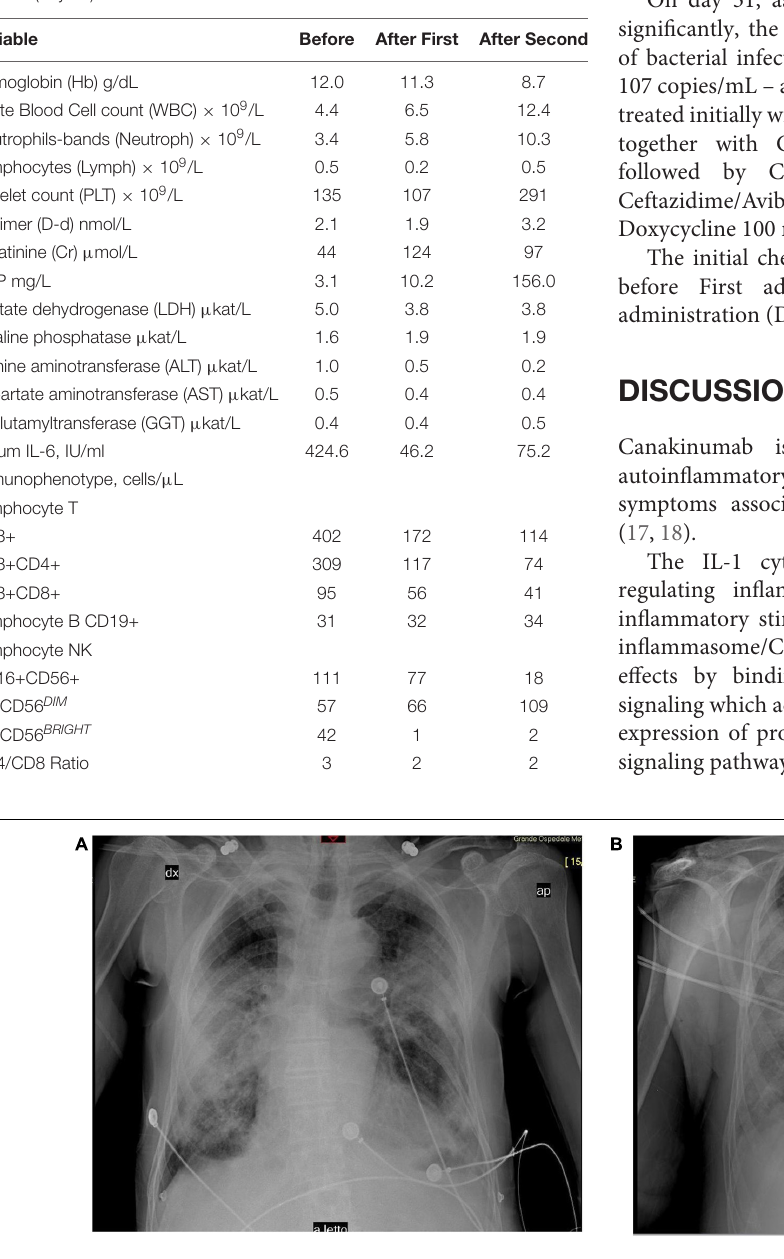
FIGURE 2 | (A) Before the first administration of canakinumab, the chest X-ray shows interstitial changes, ground glass opacities, and multifocal and bilateral effusions. (B) After second administration, the chest X-ray shows the extensive bilateral opacities and bilateral effusions, concomitant to bacterial superinfection.